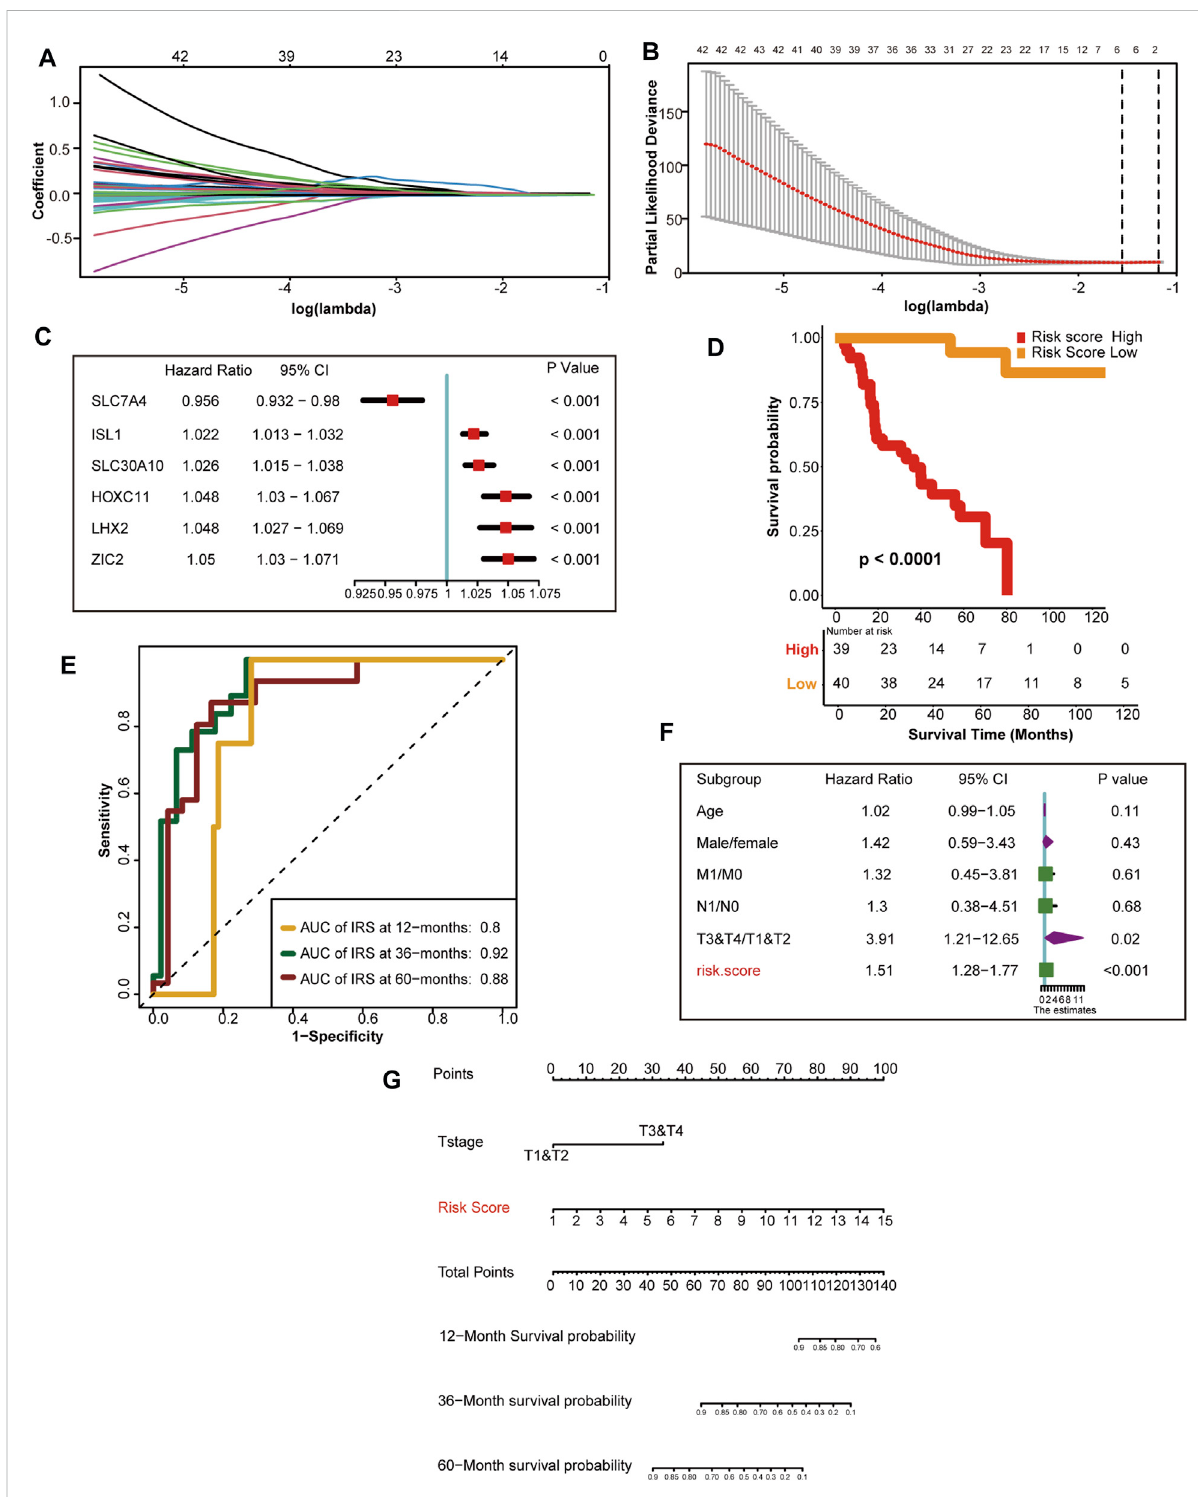
FIGURE 3 DevelopmentofHRSandtheroleinclinicalprognosisprediction. (A) LASSOcoef fi cientpro fi lesof143hypoxia-relatedprognosticDEGs (B) Ten-fold cross-validationfortuningparameterselectionintheLASSOmodel.Thetwodottedverticallinesaredrawnattheoptimalvalueusingtheminimumcriteria. Optimal hypoxia genes with the best discriminative capability (6 in number) were selected for generating the HRS (C) Forest plot of hazard rations for six optimalhypoxia-relatedprognosticgenes. (D) Survivalanalysisbetweenthetwodifferentriskscoregroup.Riskscorehighisshownredandriskscore low group is shown yellow. (E) The predictive accuracy of the HRS for survival. (F) Results of univariate Cox analysis by integrating the HRS and clinicopathological characters. (G) The nomogram used to predict the 12-month,36-month, 60-month overall